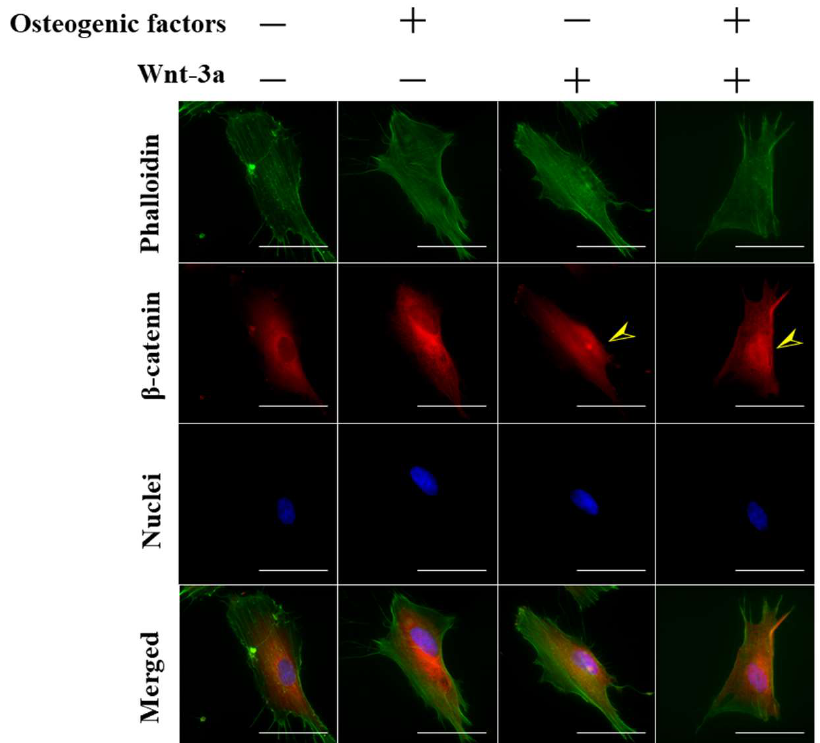
Figure 1. Fluorescence observation of the nuclear translocation of β -catenin upon stimulation with Wnt-3a. HPLFs were seeded at a density of 1.25 × 10 4 cells/cm 2 and the medium was changed after one day. Fifteen min later, cells were observed. The cells were fixed and stained with Alexa Flour ® 488-labeled phalloidin for actin (green), anti- β -catenin for β -catenin (red) and DAPI for cell nuclei (blue). The yellow arrows indicate the areas of nuclear migration. They were viewed through a fluorescence phase-contract microscope at 100 × magnifications (scale bar: 100 µ m). Nuclear translocation of β -catenin was observed in Wnt-3a-treated HPLFs, whereas that of untreated Wnt-3a was